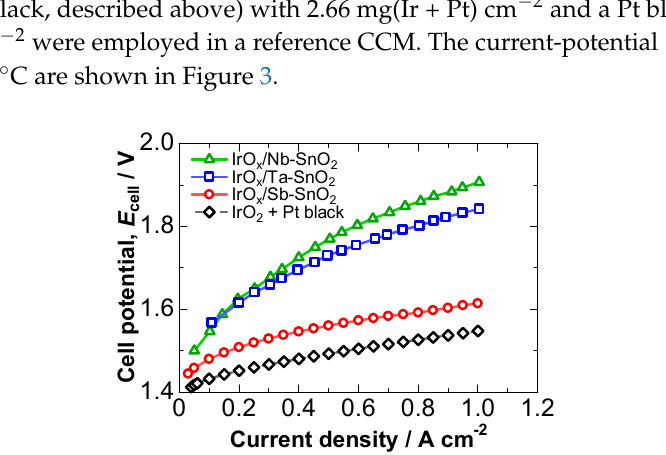
Figure 3. Steady-state I-E curves of single cells with various anodes and Pt/GCB cathode at 80 °C. Ultrapure water was supplied to the anode with a flow rate of 40 mL min −1 . The cathode compartment was purged with H 2 .